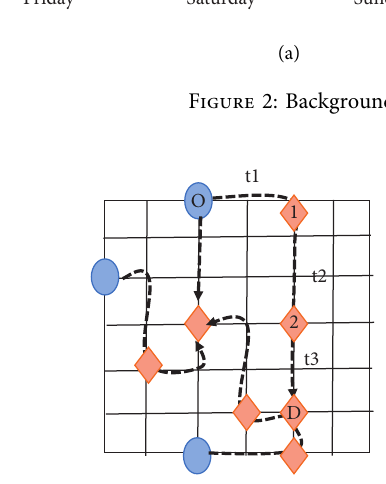
Figure 3: Relationship between the OD pair and the real